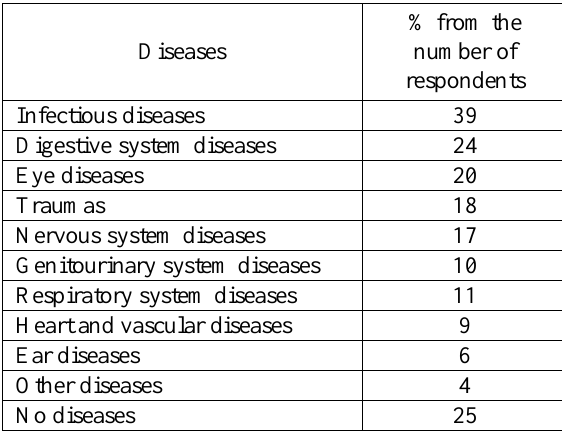
Table 4. Diseases, suffered by students during the study at university, 2012